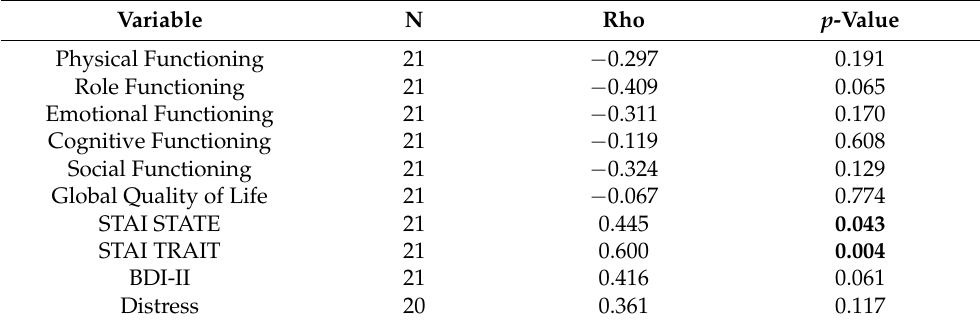
Table 6. Spearman’s correlation coefficient between psychometric variables and concern about quality of care. Variable N Rho p